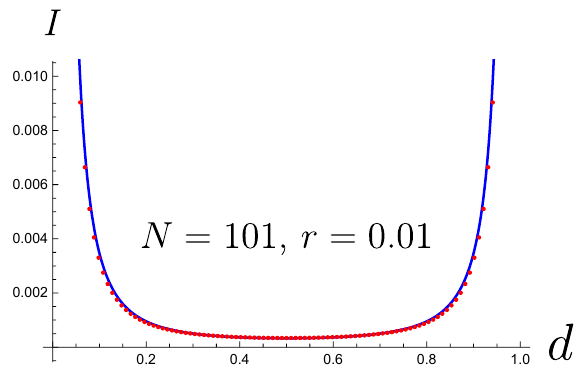
Figure 2 . Mutual information for two intervals. We take N = 101 and set the parameter r as r = 0 . 01 (length of the intervals is rL ). The red dots represent the mutual information for some values of d . The blue curve represents the large N result